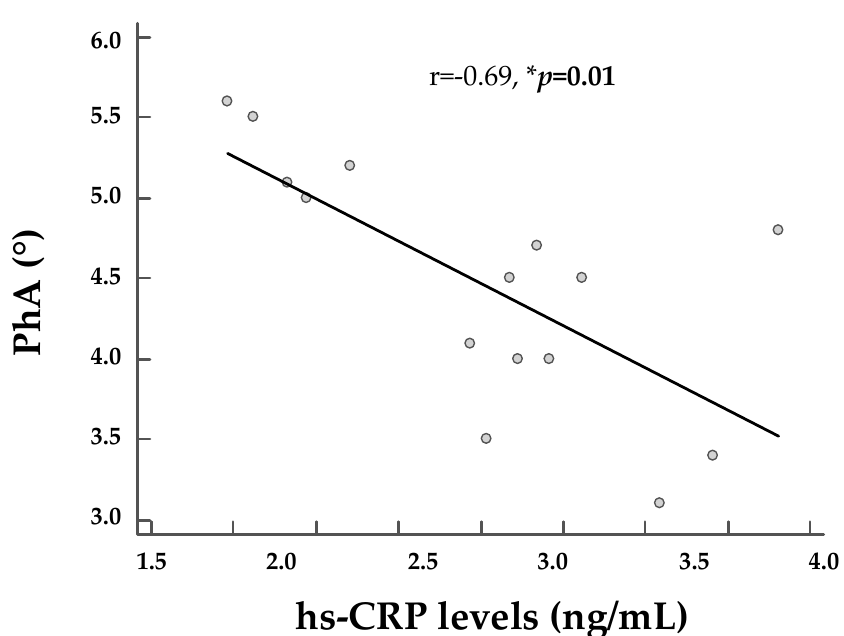
Table 3. Multiple regression analysis models (stepwise method) with the PhA as dependent variable to estimate the predictive value of hs-CRP levels, BMI, waist circumference, and BIA parameters in PWS adults.